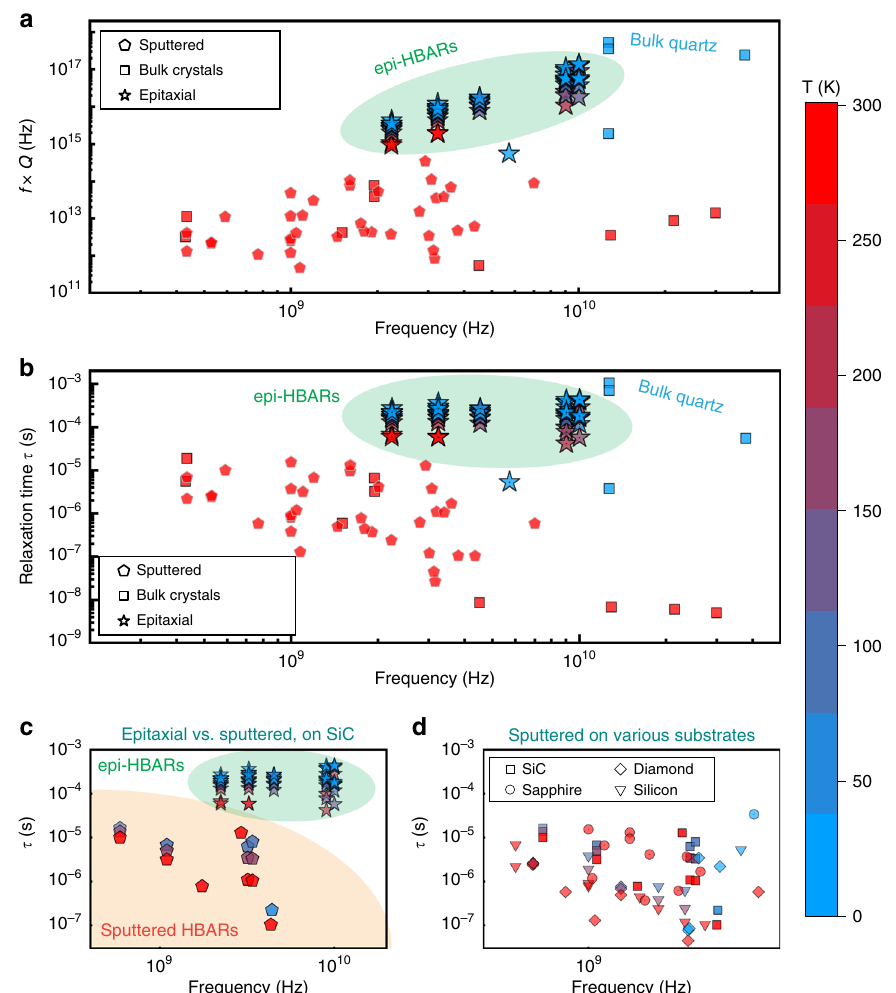
Fig. 4 The case for epi-HBARs. A comparison of ( a ) the f × Q product and ( b ) phonon relaxation time ( τ ) of selected epi-HBAR phonon modes (stars) from this work, with published values for overtone mode solid BAW resonators (thick, millimeter scale single-crystal bulk devices) (squares) and sputter- deposited HBARs (thin fi lm polycrystalline transducers on low-loss substrates) (pentagons). The measurement temperature for each data point is indicated by color. Only massive plano-convex quartz bulk resonators 6,7 using optomechanical transduction, and measured at cryogenic temperatures, demonstrate phonon relaxation times higher than that of the epi-HBARs, which exhibit τ > 500 μ s for microwave frequencies. c A comparison of epi- HBARs and sputtered HBARs, both with SiC as the substrate, validates that even with low-loss substrates the quality of the transducer heterostructure is critical to achieving high phonon lifetimes. d A study of only sputter-deposited HBARs on various low-loss substrates does not clearly indicate the superiority of any particular substrate